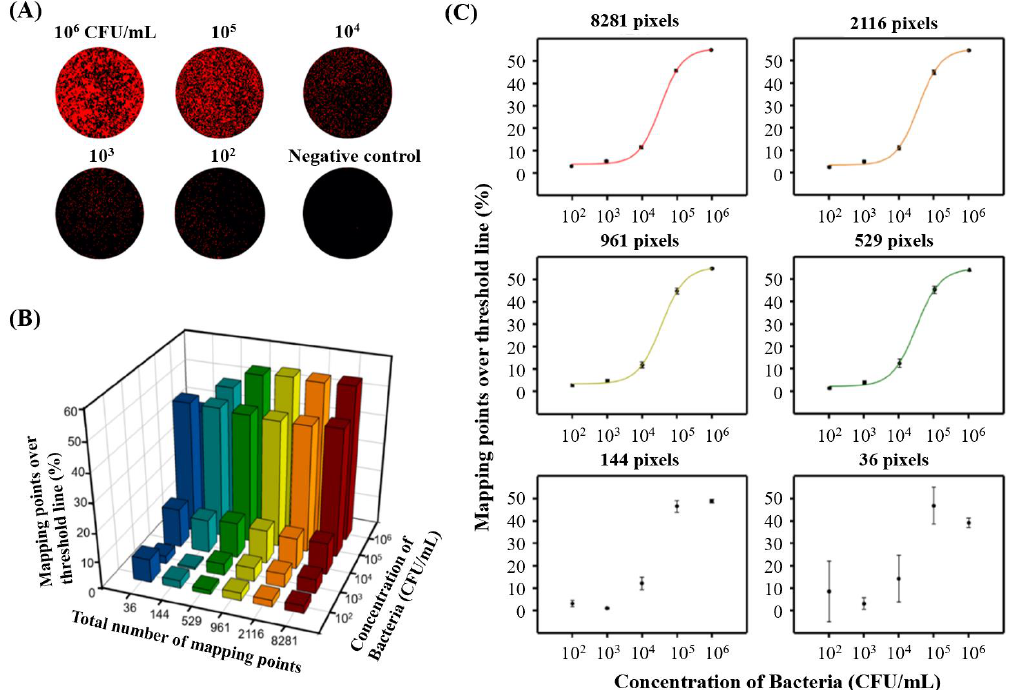
Figure 4. Quantitative evaluation of Salmonella enterica serovar S. typhimurium by SERS imaging. ( A ) SERS mapping images measured with a peak intensity at 1615 cm − 1 for different concentrations of S. typhimurium . ( B ) Mapping points over the threshold line (%) in the 0 to 10 6 CFU/mL range. ( C ) Corresponding standard calibration curves as a function of bacteria concentration for different numbers of total mapping points [28].